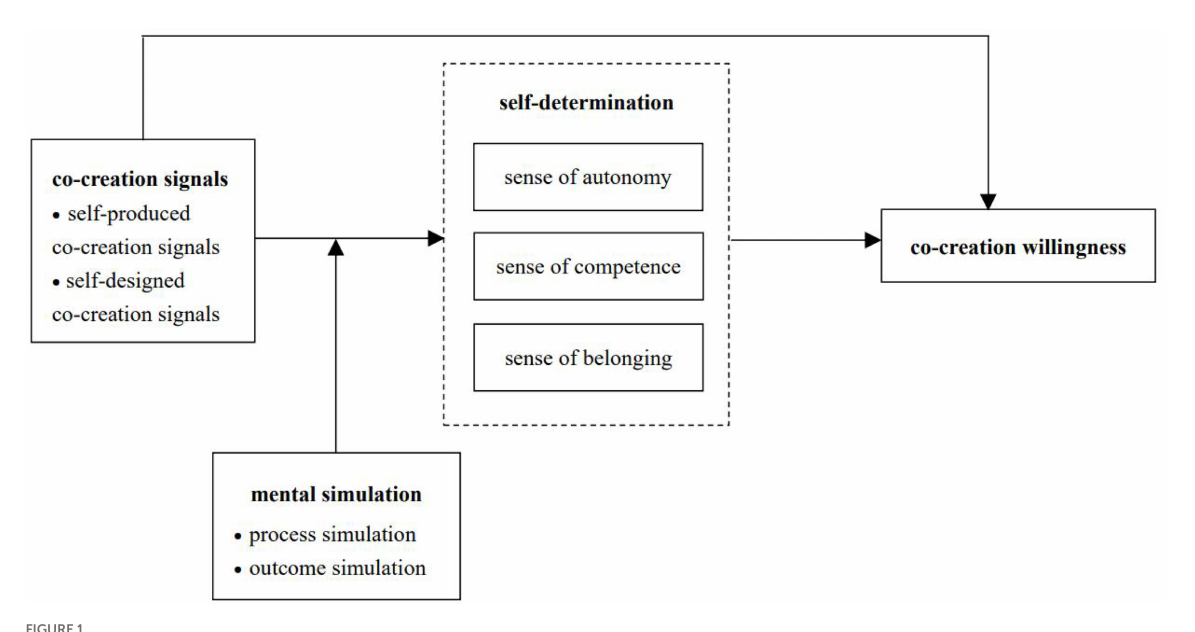
FIGURE 1 Theoretical